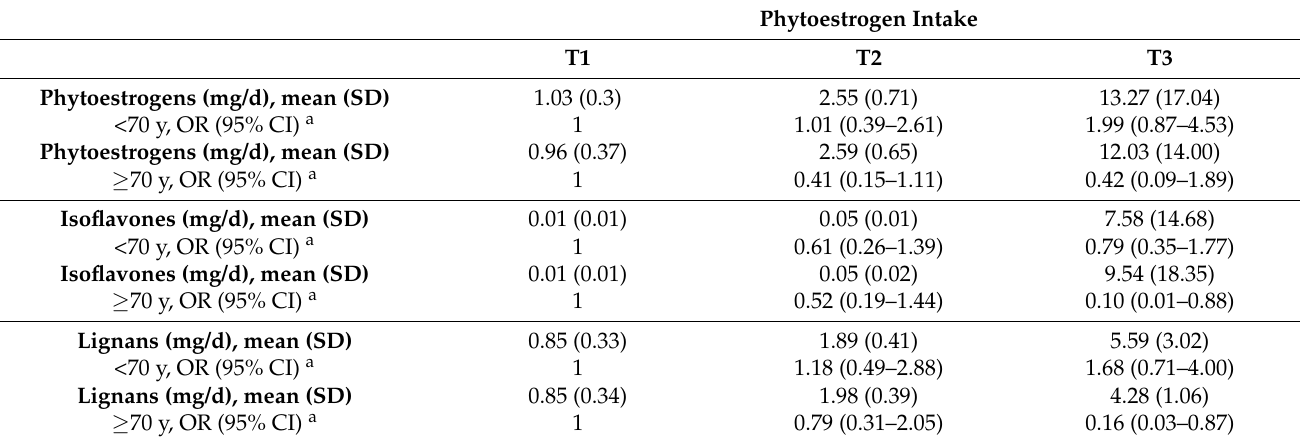
Table 4. Association between total isoflavone and lignan intake, and impaired cognitive status by age